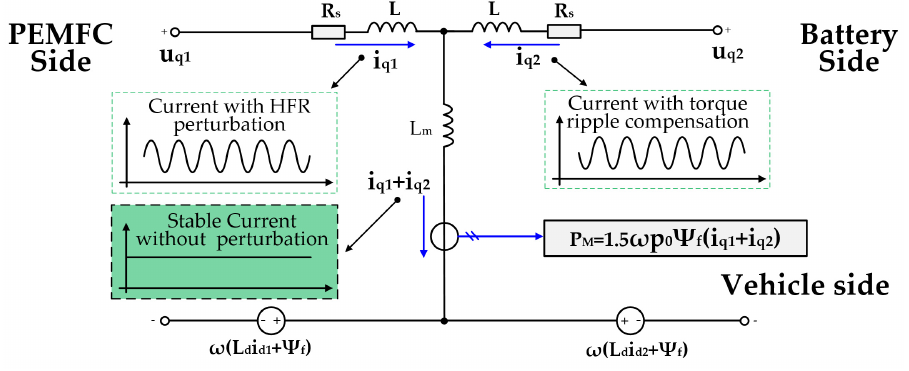
Figure 8. Q-axis equivalent circuit of the dual-winding motor. Figure 8. q -axis equivalent circuit of the dual-winding